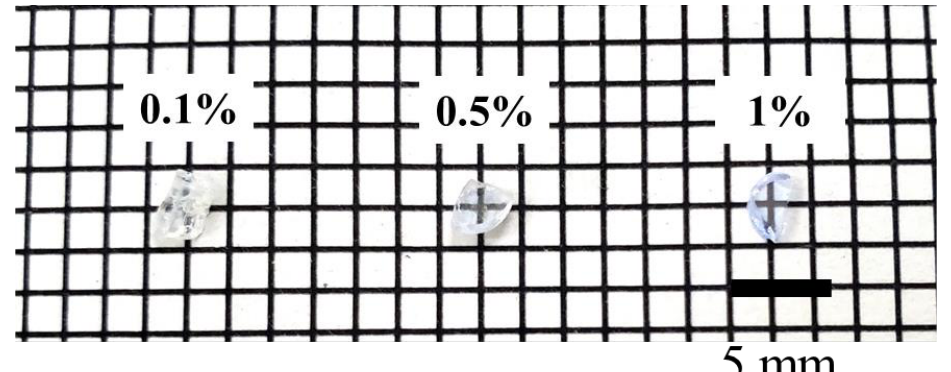
Figure 1. Photograph of Nd-doped CaWO 4 .